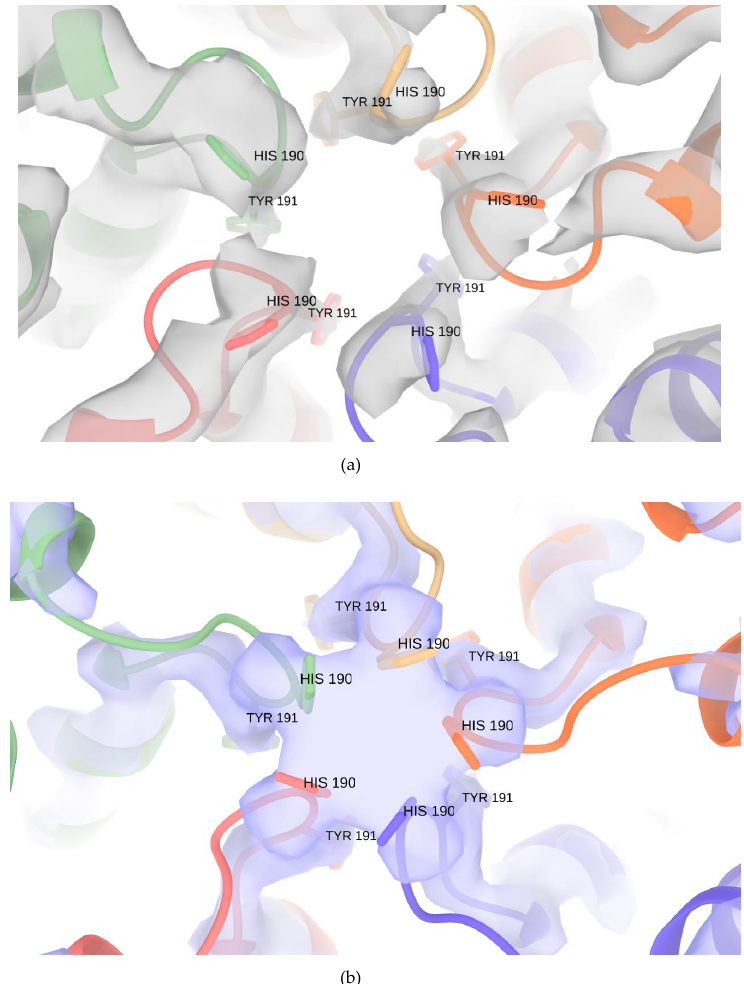
Figure 5. Conformation comparison of the crystal encapsulin structure (PDB:3DKT) fitted in the X-ray 2fo-fc map (grey) ( a ) and Encap / IDM complex ( b ) refined model fitted in the EM density map (purple) at the fivefold pore.